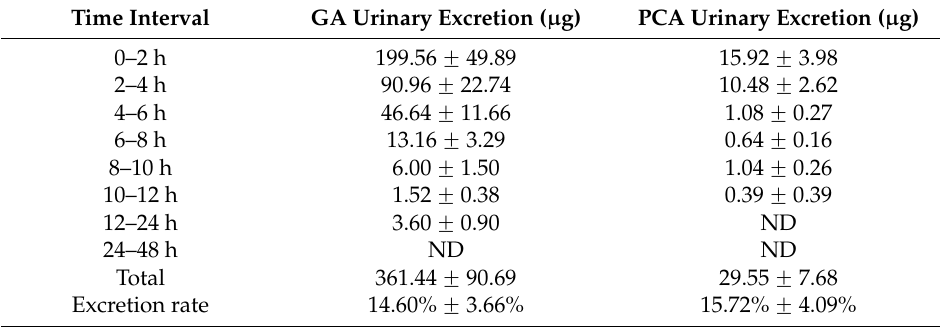
Table 2. GA and PCA in rat urine from 0 h to 48 h after oral administration 60 mg/kg of P. capitatum extract ( n = 6).